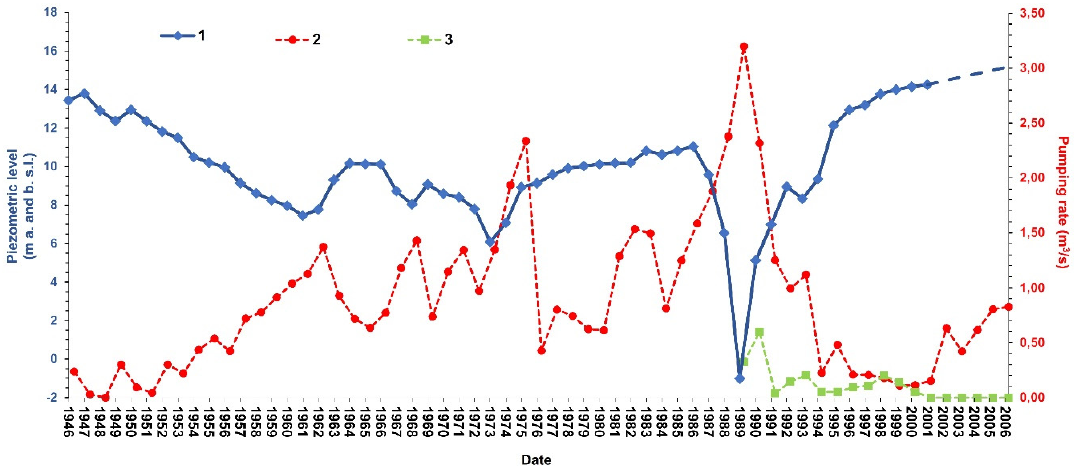
Figure 3. Piezometric level and pumping rates. 1) Lufrano well-field piezometric level; 2) pumping rate of the Lufrano well field, 3) pumping rate of the Acerra well field.